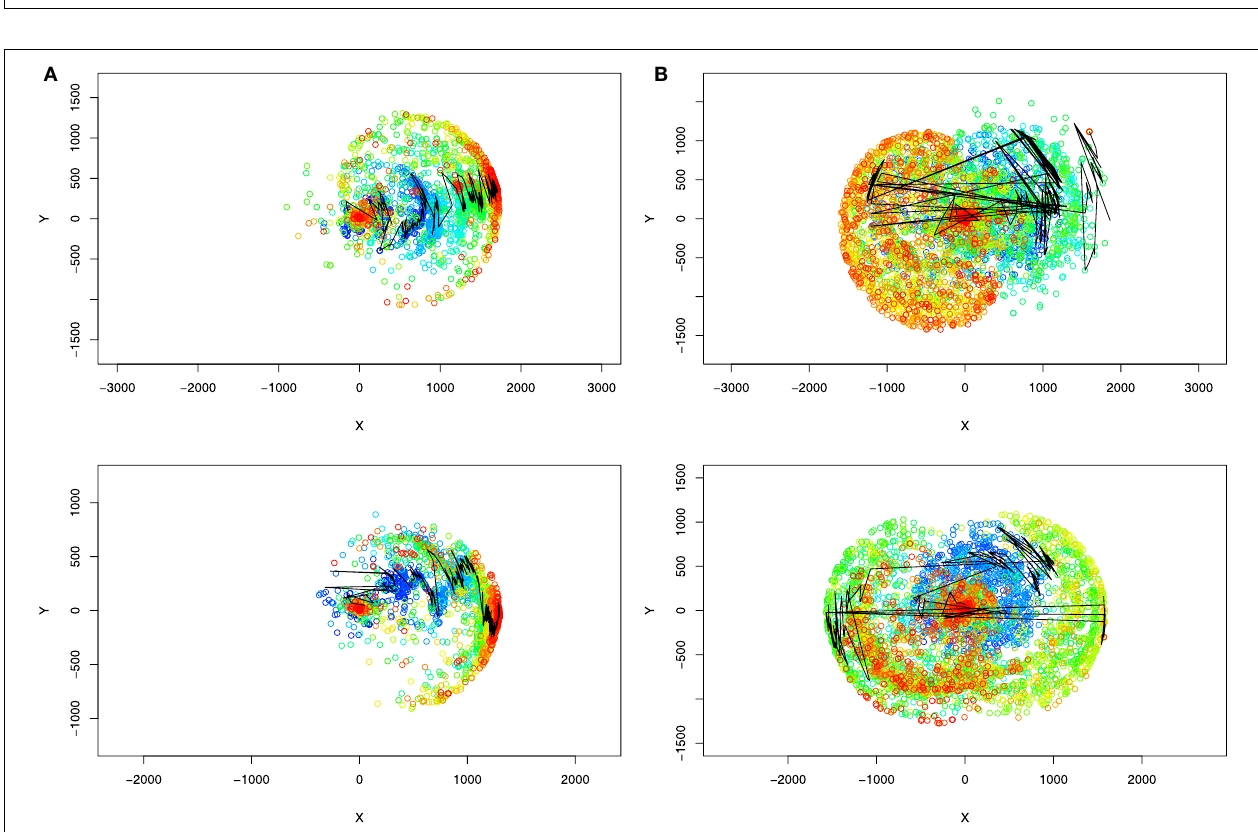
FIGURE 7 | GRN-driven actuation: performance of novelty search compared to the NEAT algorithm on the problem of co-evolving morphology and controller of soft-bodied, swimming (A) and walking (B) animats . Solid lines show mean best fitness in a given generation from 20 evolutionary runs of each type of experiment. Dashed lines show 95%, bootstrapped confidence intervals for the means. (A) Aquatic environment, (B) terrestrial environment.